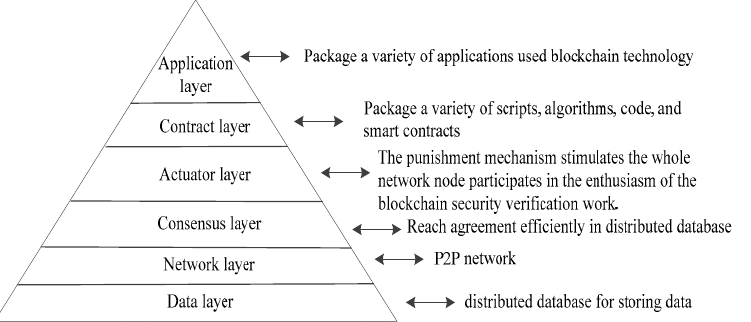
Figure 1. Basic architecture model of blockchain.